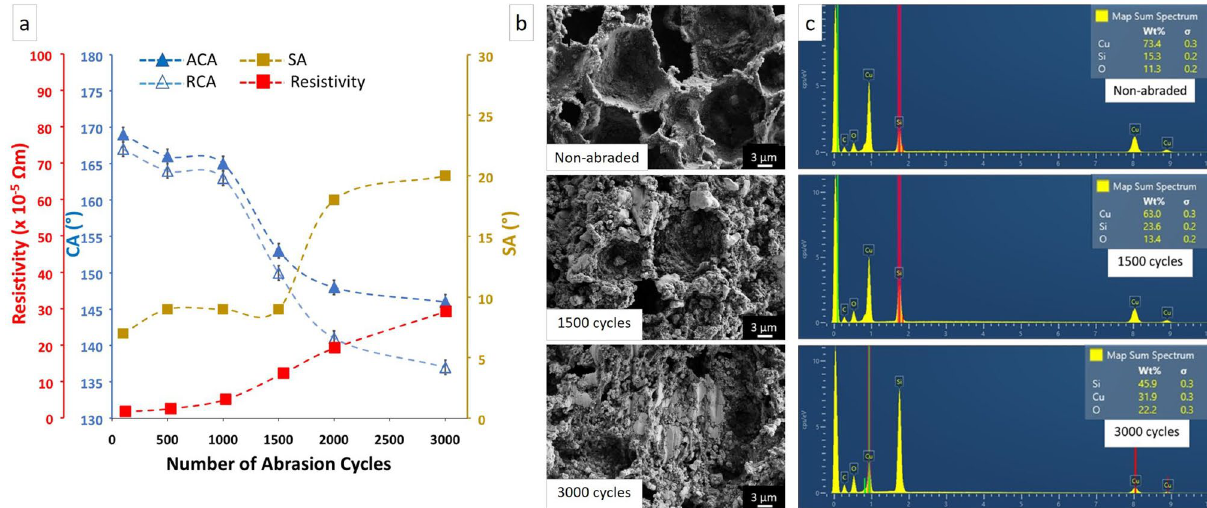
Figure 5. ( a ) The contact angles, sliding angles, and resistivity of abraded material from 100 to 3000 cycles. ( b ) The SEM images of surface structures of non-abraded and abraded materials after 1500 and 3000 cycles of abrasion. ( c ) EDX analysis of PDMS/Cu material for non-abraded, after 1500 and 3000 cycles of cycles due to the reduction of Cu content and the destruction of hierarchical structures. Wang et al. reported that when a fluorinated PDMS composite was subjected to the sandpaper-abrasion test, conductivity and supe- rhydrophobicity were maintained for 80 abrasion cycles 44 , while our composite material maintains its properties for 1500 abrasion cycles. Wang et al. and Luo et al. showed that the static contact angle remained above 150° after 50–60 abrasion cycles 43,46 . However, no information was provided on the sliding angles or contact angle hysteresis, and thus the effect of abrasion on superhydrophobicity cannot be assessed. The surface morphologies of non-abraded and abraded samples are shown in Fig. 5b. Although some round- ing of structures is visible after 1500 cycles, the main surface features were preserved after 1500 cycles of sandpa- per-abrasion test. As the material was subjected to 3000 cycles, destruction of finer structures can be observed and the superhydrophobicity was gradually lost. The EDX analysis shows that the Cu content decreased slightly from 73.4 (non-abraded) to 63.0 wt% after 1500 cycles of abrasion and then significantly decreased to 31.9 wt% after 3000 cycles of abrasion due to the damage of hierarchical structures (Fig. 5c). The EDX results also show the increase in silicon and oxygen signals, which are likely due to more PDMS being visible after some of the copper was abraded away. On the other hand, the constant supply of PDMS monomers to the surface to coat freshly exposed copper is supposedly responsible for the long-lasting superhydrophobicity. This is very different compared to superhydrophobicity achieved via polymer coating: first of all, our polymer is mostly under the surface; and second, we have millimeter thickness, which is an ample supply. Nanostructured copper surface with copper oxide (CuO) has been found to exhibit low friction and improved wear resistance because wear debris is not on the surface but inside the microstructures 47 . Only few conductive superhydrophobic surfaces have undergone mechanical durability tests. These include a fluorinated PDMS composite 44 and a rubber composite 46 . The superhydrophobicity and conductivity were maintained after 1000 stretching cycles and 80 abrasion cycles for the PDMS composite 44 and after 100 stretch- ing cycles and 60 abrasion cycles for the rubber composite 46 . Luo et al . showed the static contact angle of poly- propylene/polydopamine/Ag-nanoparticle/PDMS composite remained above 150° and conductivity decreased from 89.1 to 60.0 S/cm after 50 abrasion cycles (3X less conductive than our sample after 1000 abrasion cycles) 43 . Polymer-modified Ag-nanoparticles on natural rubber were reported to exhibit superhydrophobicity, elasticity, and conductivity without fluorination 42 . These structures were not subjected to abrasive tests, even though they survived kneading, torsion, and water impact tests. Bending tests. Figure 6a shows the advancing, receding contact angles, and resistivity after cyclic bend test from 1000 to 10,000 cycles (Movie S3 in the supplementary material). The results show a small decrease in both advancing and receding contact angles after 10,000 bending cycles; the advancing contact angle decreased to 163 ± 1° and the receding contact angle was reduced to 160 ± 1°, so the superhydrophobic property of the mate- rial was preserved after cyclic bend test. The resistivity increased to 5 × 10 –5 Ωm after 1000 bending cycles, and to 90 × 10 –5 Ωm after 10,000 cycles due to deformation of hierarchical structures. The resistivity increase was more pronounced after 10,000 bending cycles compared to 10,000 stretching cycles. This is likely due to compressive failure that occurred in the bending test (Fig. 6b). Resistivity as a function of bending was not reported by Yao et al. and Asthana et al. 29,45 As can be seen in Fig. 6b, the surface did not show any changes after 1000 cycles, while significant deformation in the surface structures can be observed after being subjected to 10 000 bending cycles.